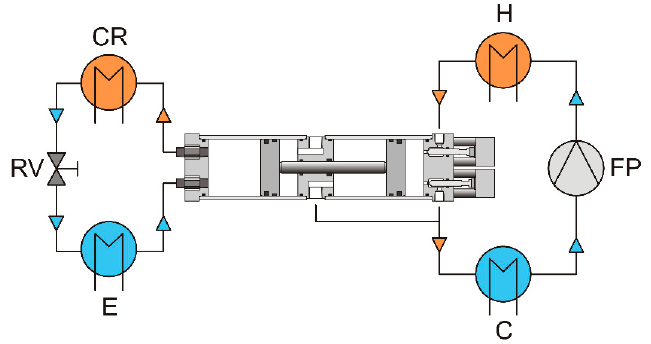
Figure 11. Scheme of the experimental setup. The setup included the compressor itself and power and refrigeration loops. The power loop consisted of a heater (H), a piston feed pump (FP) and a cooler/condenser (C). The recuperator was not used in this scheme. The refrigeration/refrigeration loop consisted of a condenser (CR), an evaporator (E) and a control valve/throttle (RV). All heat exchangers were brazed plate heat exchangers (SWEP). The regulating valve/throttle was a Swagelok metering needle valve. The IE compressor had two cylinders with internal diameters of 80 mm; the piston stroke was 100 mm. The R134a refrigerant was used as the working fluid in both the power and refrigeration